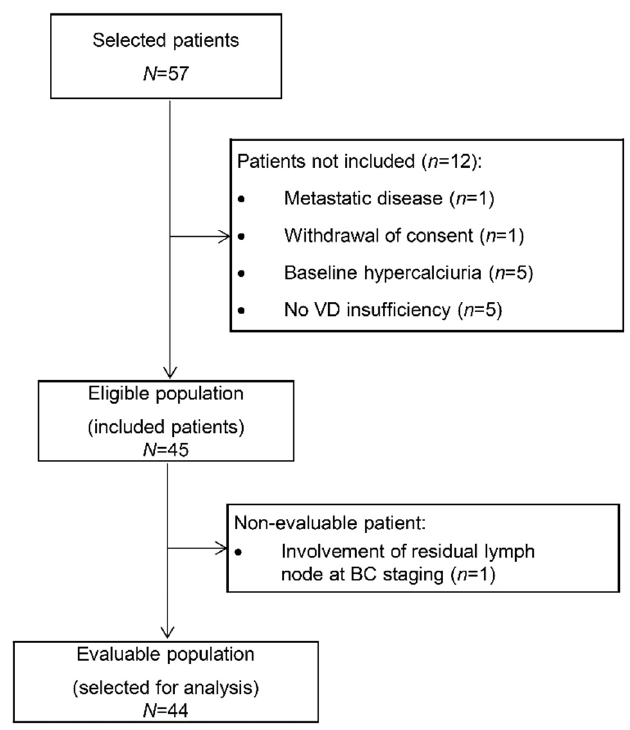
Figure 1. Study flowchart (VD: vitamin D).